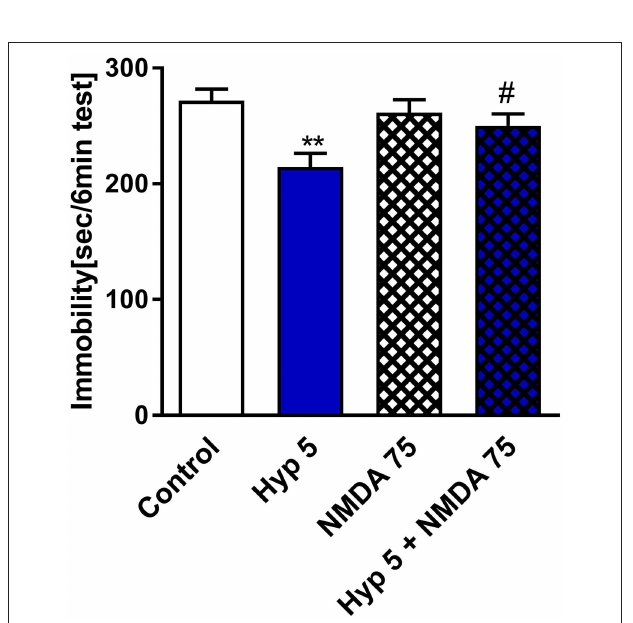
FIGURE 4 | The effect of pretreatment with glutamate system modulator on hyperforin activity in the TST in mice. NMDA (75 mg/kg; i.p. ) was administered 15min before hyperforin (2.5 mg/kg; i.p. ). TST was carried out 60min after hyperforin administration. ** p < 0.01 vs. control, # p < 0.05 vs. hyperforin, n = 5–7; [ F (3,22) = 4.957; p = 0.0089]. All data was analyzed by one-way ANOVA and Newman-Keuls multiple comparisons test. All values are expressed as mean ±